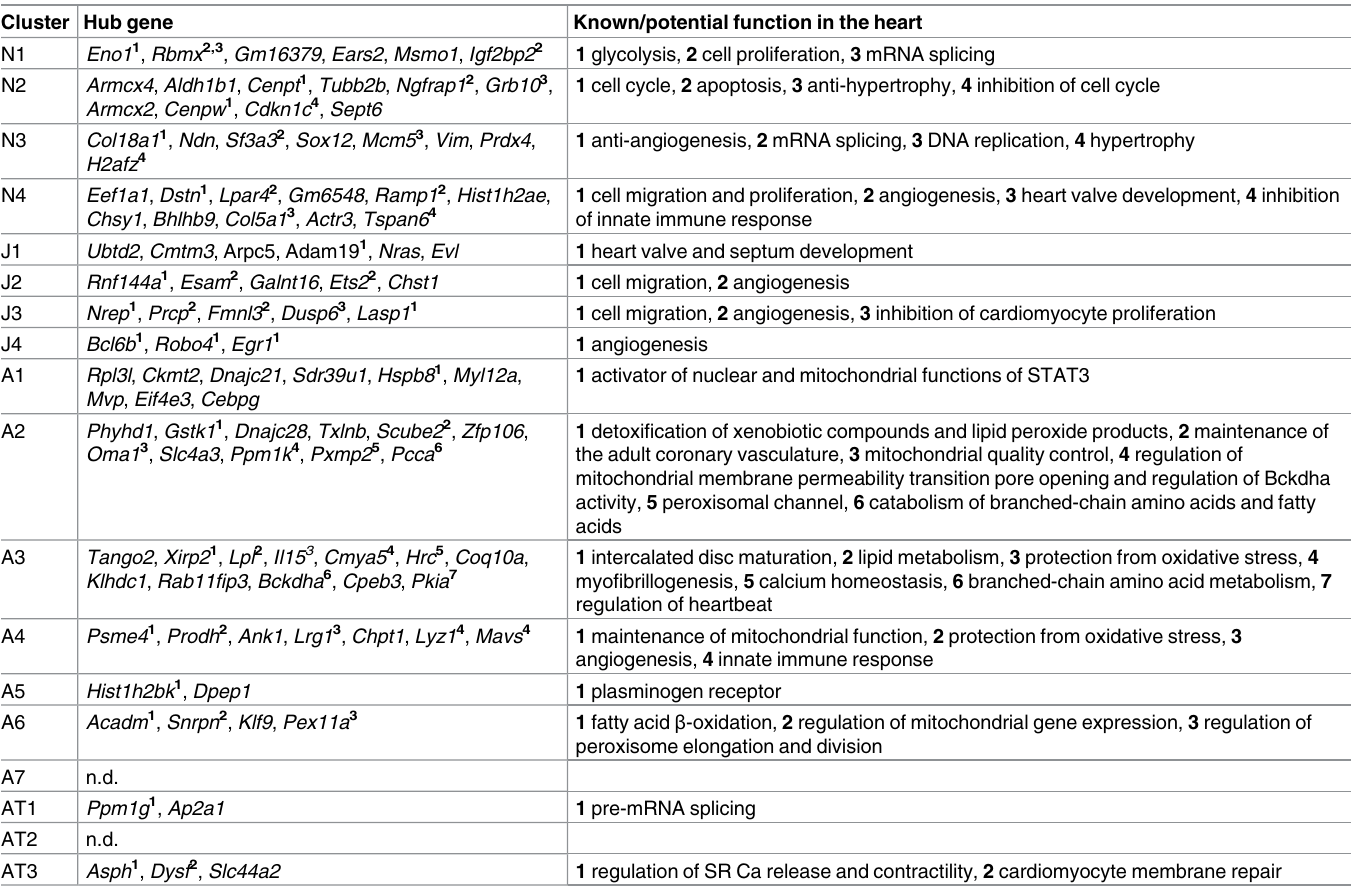
1 regulationof SR Ca release and contractility, 2 cardiomyocyte membrane repair Hub genes ranked in top 5% are shown. In clusters A7 and AT2, hub gene was not able to be determined because the scale-free topology criterion was not satisfied in networks of these clusters (see text for details). n.d.: not